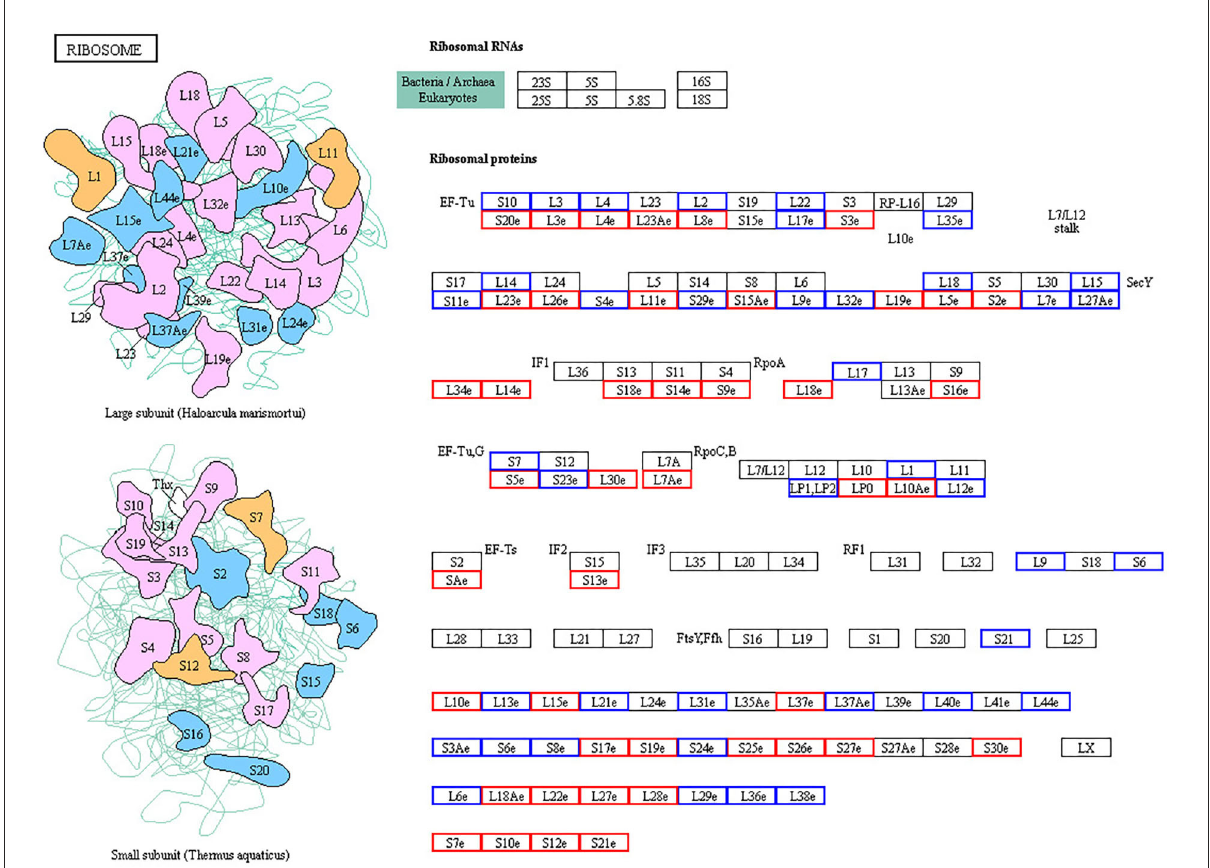
FIGURE6 Differentially expressed ribosomal proteins between the 15-day and 3-month age groups. The KEGG pathway chart shows differentially expressed proteins; for more details, please refer to: http://www.genome.jp/kegg/document/help_pathway.html. The gene products in a white background frame represent the proteins that have not been identified in this experiment, the gene products in a blue frame are detected but have no differences, and the gene products in a red frame are upregulated proteins detected in this